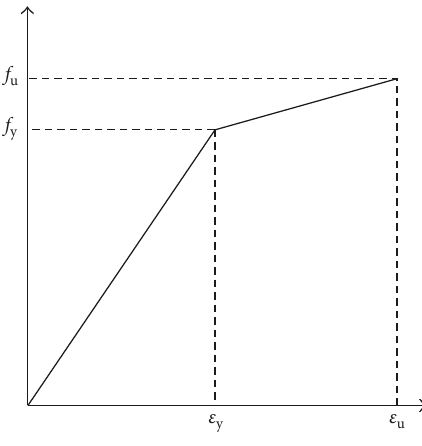
Figure 4: The diagram of the CEB-FIB bond-slip